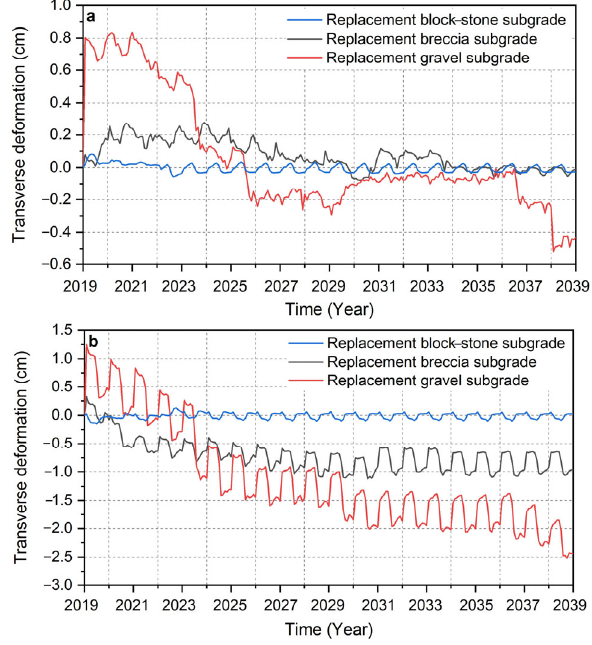
Figure 19. Transverse deformation curves at the road centerline and the shoulder of the three sub ‐ grade structures in Case 2: ( a ) at the road centerline and ( b ) at the shoulder.